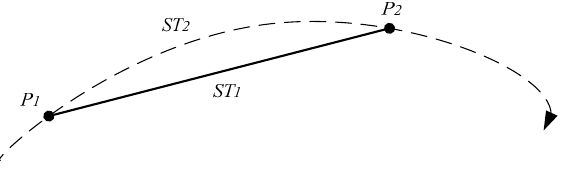
Figure 2. A sub-trajectory segment and a natural sub-trajectory segment.